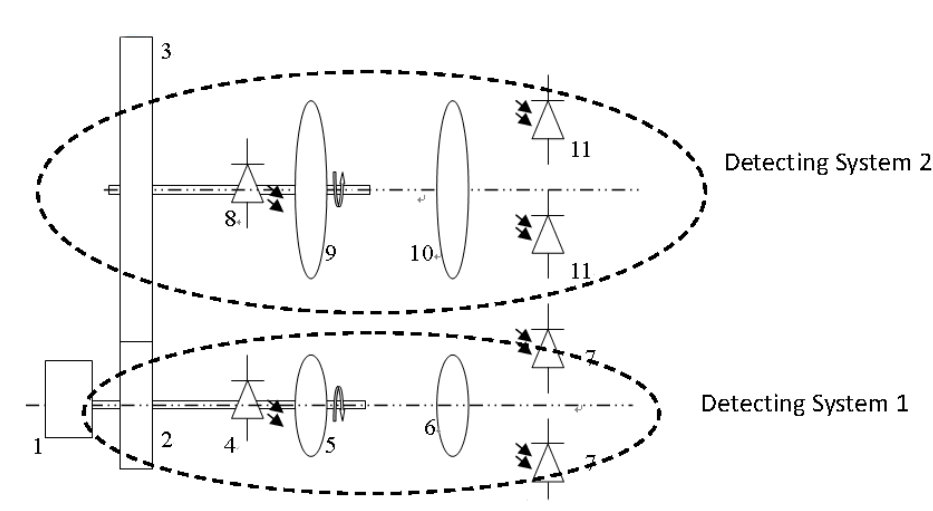
Figure 2. Schematic diagram of the